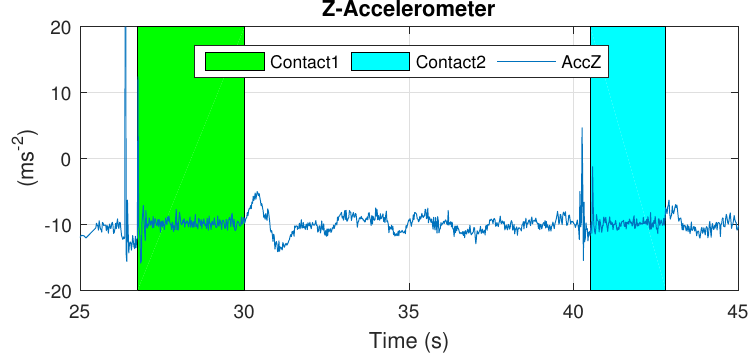
Figure 18. Z-accelerometer—Grazalema bridge experiments.